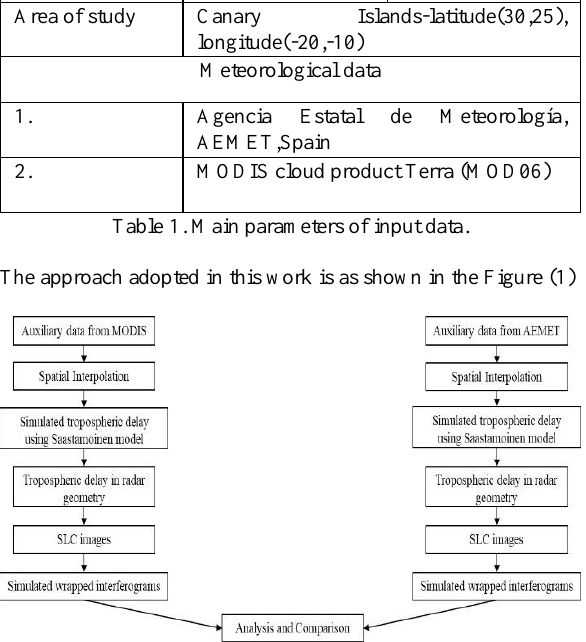
Figure 1. Flowchart for the methodology.